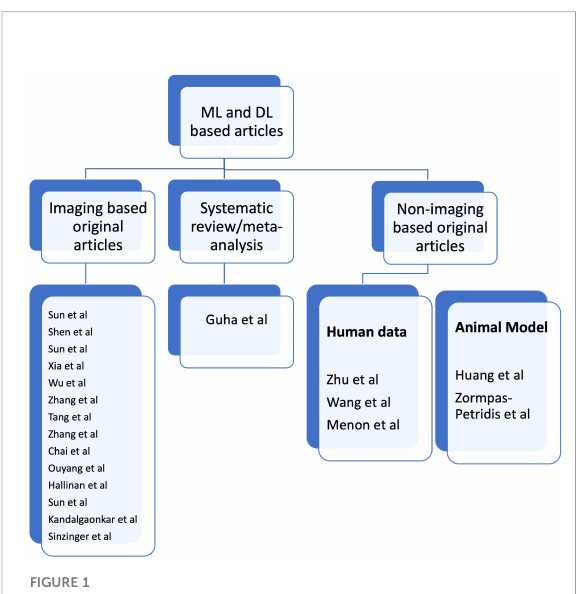
FIGURE 1 List of authors based on type of articles submitted towards research